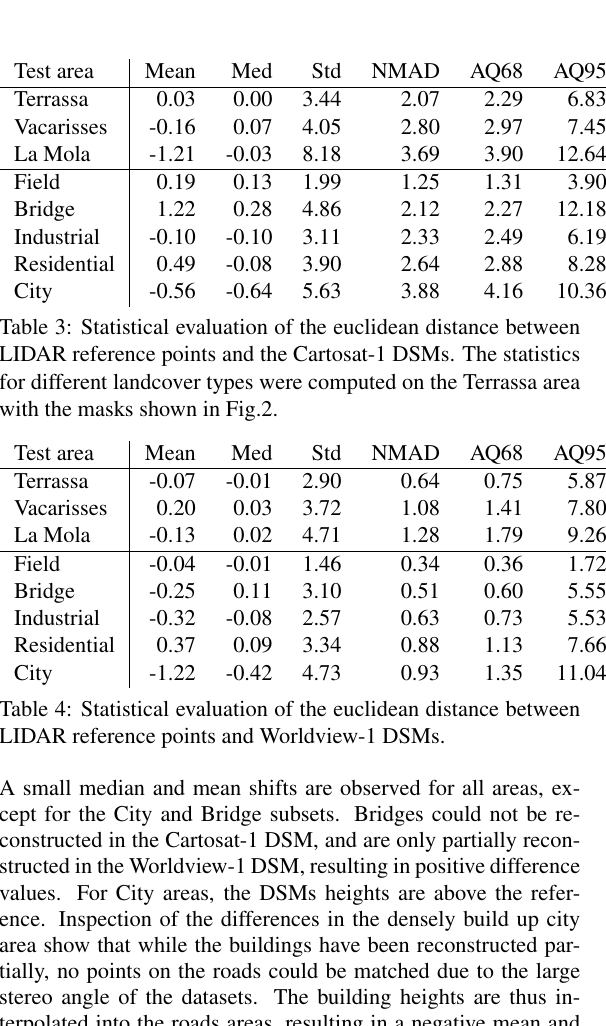
LIDAR data. Only slope bins for which more than 10000 LIDAR points were available are plotted. A linear increase of the error is visible in the Vacarisses test area up to a slope of 35 degrees. After that, the error increases sharply, probably due to significant foreshortening effects, as the forward looking Worldview-1 im- age has been acquired with an off-nadir angle of 30 degrees. A similar effect is visible for the La Mola area, where the error in- creases sharply for slopes greater than 45 degrees. Contrary